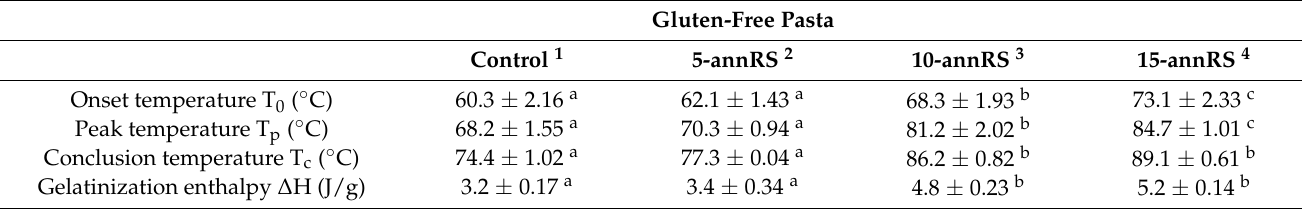
Table 3. Thermal properties of gluten-free macaroni containing resistant starch from annealed white sorghum starch